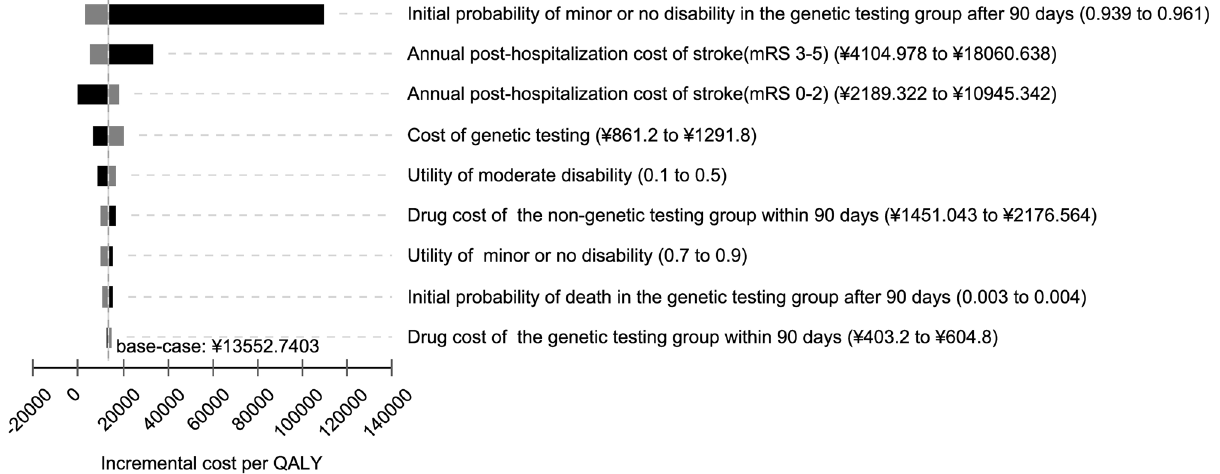
Figure 1. One-way sensitivity analyses on incremental cost-effectiveness ratio (ICER) gained by genetic testing. Numbers listed in parentheses indicate the range of the variable. Dark-shaded bars represent the lower bound of the variable range. Light-shaded bars represent the upper bound. Solid vertical lines represent the ICER of the clopidogrel-aspirin regimen at the base-case scenario (CNY 13,552.74/QALY). QALYs, quality adjusted life